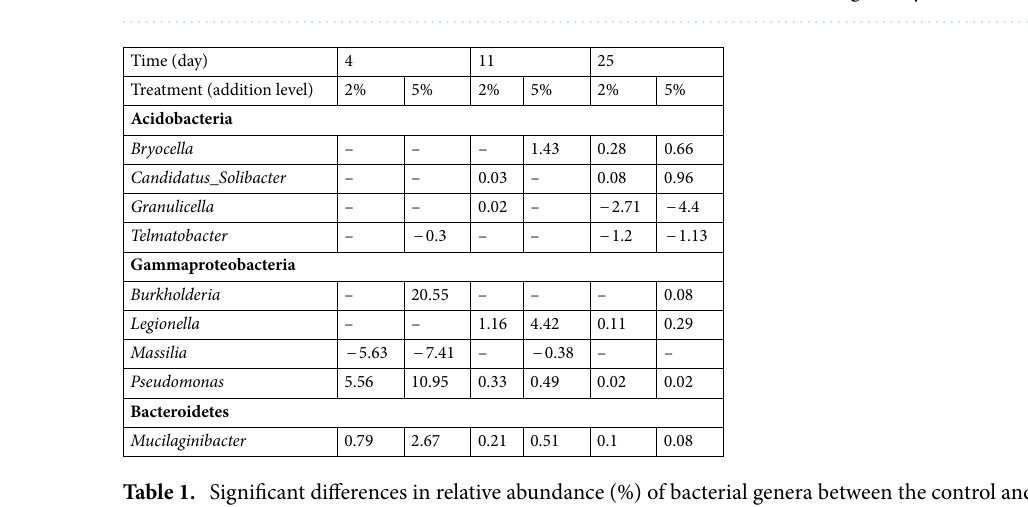
Figure 4. The relative abundance of the main phyla and classes in samples amended by artificial exudates in concentration of ( A ) 2% of total DOC, ( B ) 5% of total DOC and ( C ) control during 25 days incubation.